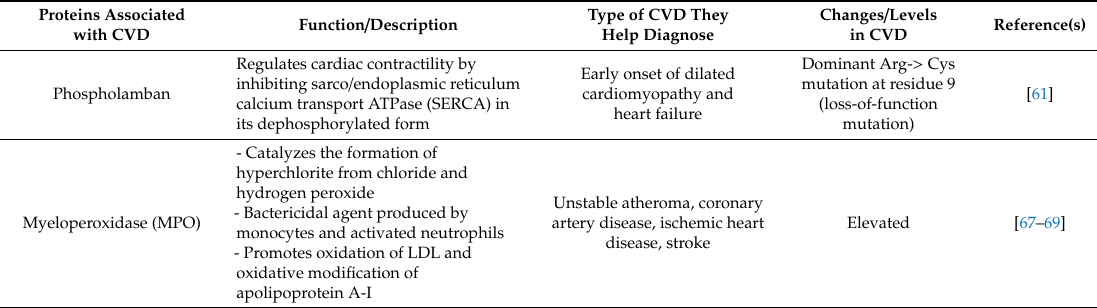
Table 2. Early stage protein biomarkers of cardiovascular